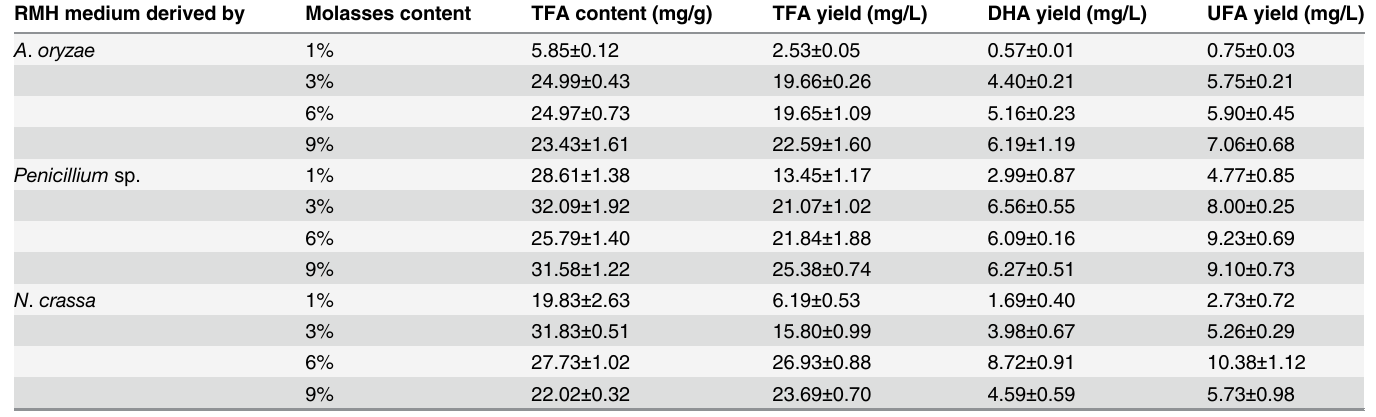
Table 2. Effect of supplemented waste molasses on lipid production by C. cohnii on individual RMH medium.